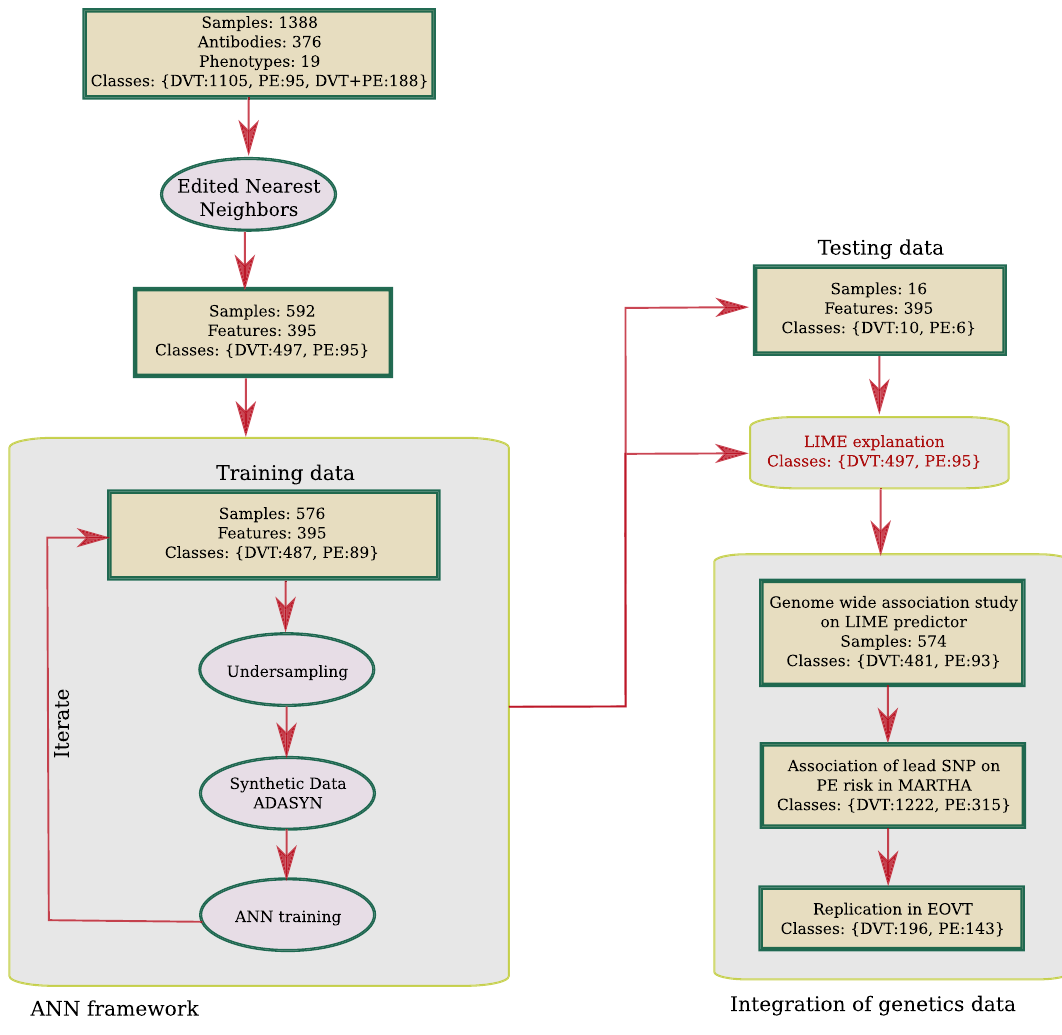
Figure 1. Analysis workflow of the present